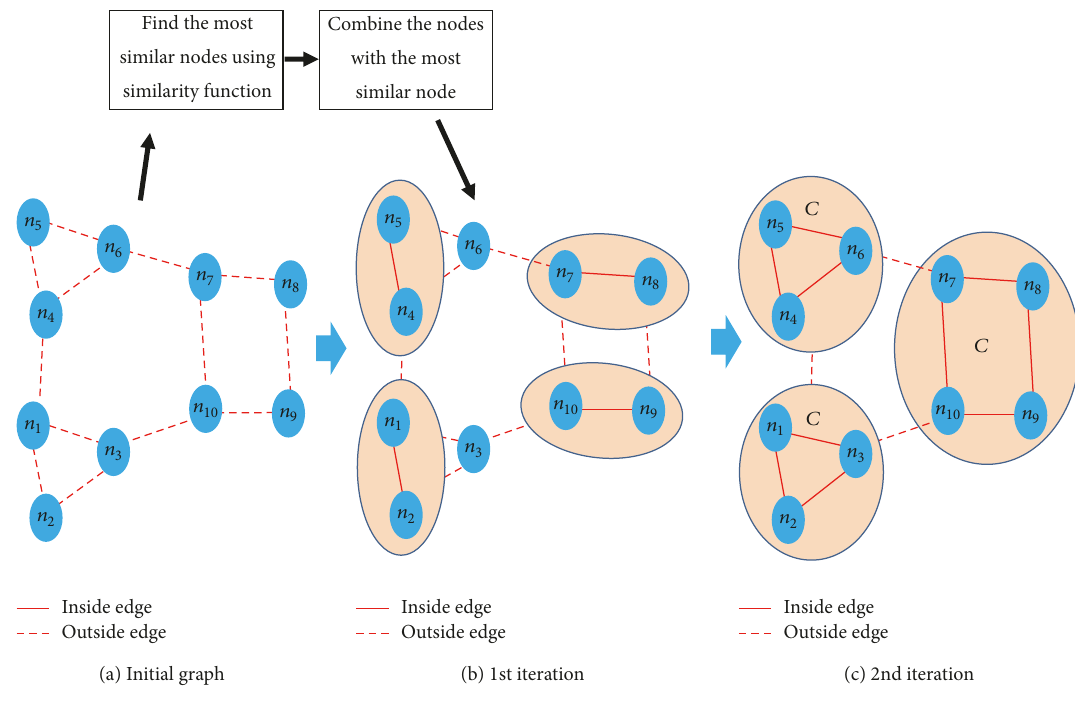
Figure 1: Example of agglomerating